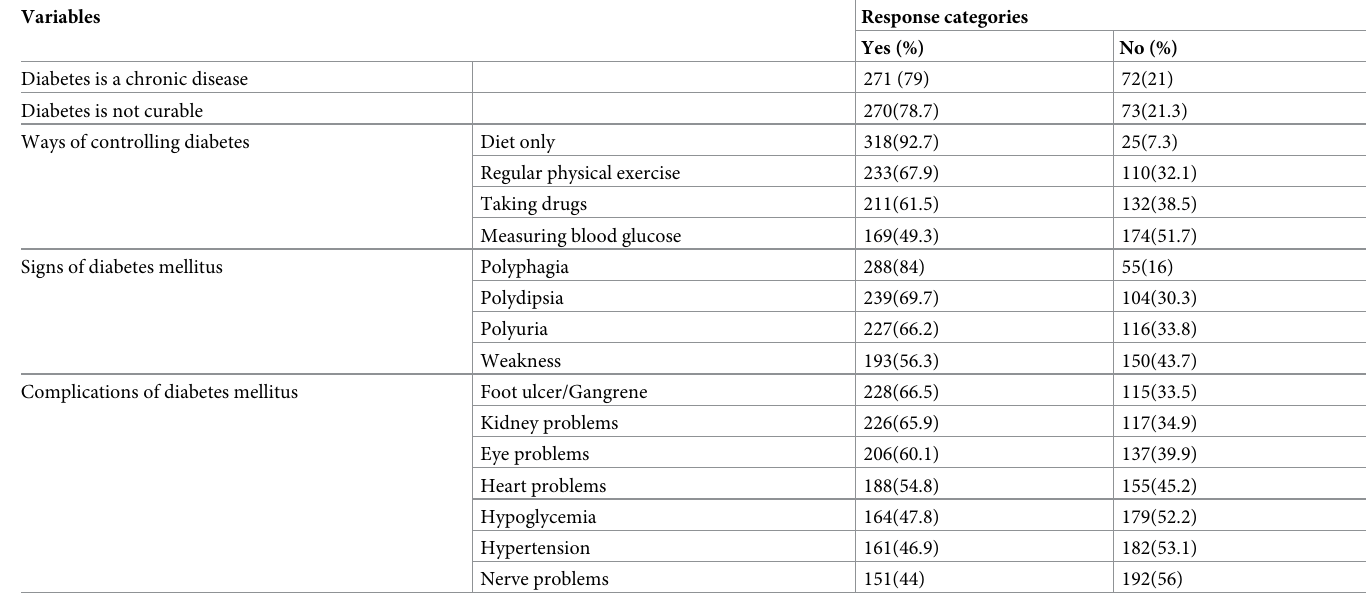
Table 2. Knowledge about diabetes mellitus of patients with diabetes in Jimma University medical center, Ethiopia April 12-May 25 2020 (n = 343).